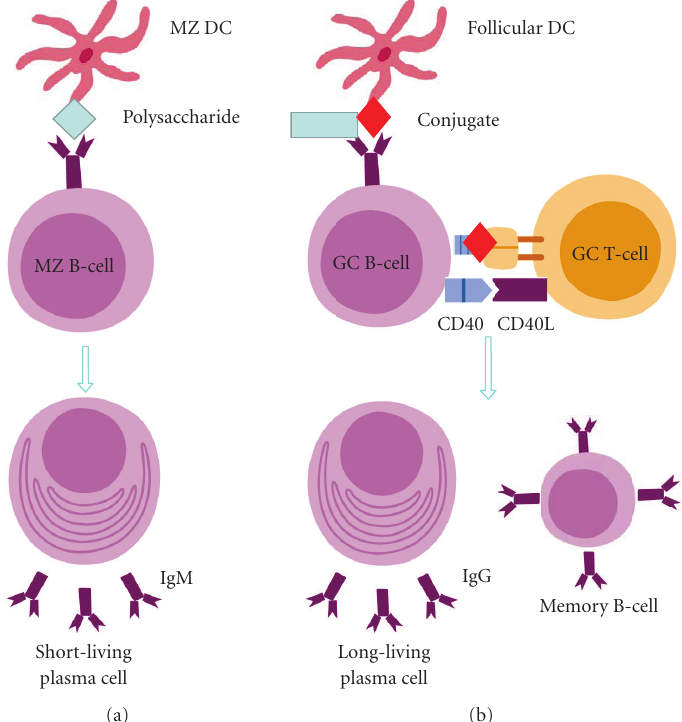
Figure 1: Schematic diagram of mechanism of action of PS and PS-protein conjugate vaccines. (a) Polysaccharide vaccines stimulate marginal zone B-cells which will proliferate in loco and di ff erentiate into short-living plasma cells, which are responsible for the rapid release of low-a ffi nity antibodies and thus first-line defence against the pathogen; (b) conjugate vaccines stimulate B-blasts that will migrate into the germinal centre, where they proliferate, undergo somatic hypermutations and isotype class switch, and di ff erentiate into either long-living plasma cells (that produce high-a ffi nity antibodies) and memory B cells. Abbreviations: CD40L (CD40 ligand), GC (germinal centre), MZ (marginal zone), DC (dendritic cell), MZ DC (marginal zone dendritic